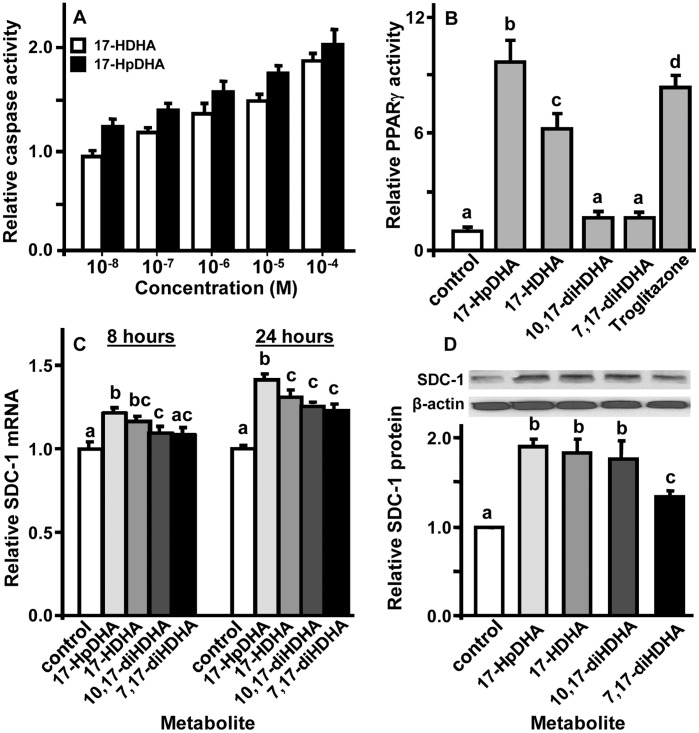
Stimulatory effects of DHA metabolites on caspase, PPARγ activity, and SDC-1 expression in PC3 cells.
A. Cells were incubated with the indicated concentration of 17-HDHA or 17-HpDHA for 24 h and caspase-3 activity was measured by Caspase-Glo® 3/7 assay. Results are presented as mean ± SD (N = 3) relative to control cells treated with the medium for the metabolites. Responses to all doses at and above 10−8 M for 17-HpDHA and at or above 10−7 M for 17-HDHA were significantly greater than that of control cells (two way ANOVA, P<0.05). B. Cells transfected with luciferase PPARγ reporter gene were stimulated for 24 h with 10 µM of the indicated metabolite (the lowest dose where all had a clear effect on cell growth) or 5 µM of troglitazone and assayed for luciferase. Values represent the mean ± SD (N = 3). Bars labeled with the same letters are not significantly different from each other; bars labeled with different letters are significantly different from each other (one-way ANOVA, P<0.05) C. Cells were treated with medium (control) or 10 µM of the indicated metabolite for 8 or 24 h and their SDC-1 mRNA was measured. Values represent the mean, ± SD (N = 3). Within each time group, bars labeled with the same letters are not significantly different from each other; bars labeled with different letters are significantly different from each other (one-way ANOVA, P<0.05). D. Cells were treated with medium (control) or 10 µM of the indicated metabolite for 72 h and their lysates were analyzed for SDC-1. The Western blot is representative of 3 independent experiments. Values in graphs represent the mean ± SEM (N = 3 independent experiments). Bars labeled with different letters are significantly different from each other (one-way ANOVA, P<0.05).